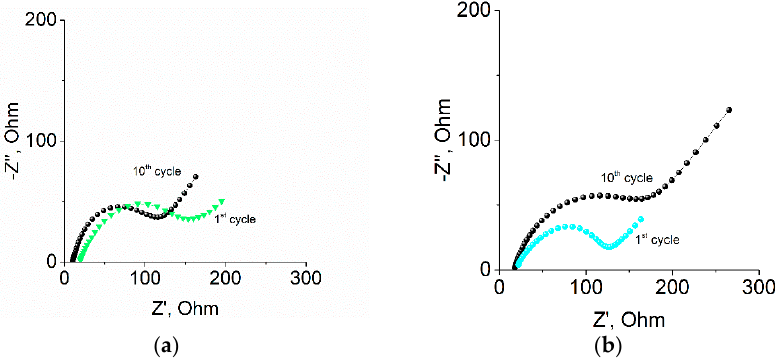
Figure 3. Nyquist plots of Ge microrods in the without-VC ( a ) and the with-VC ( b ) electrolyte solu- tions.